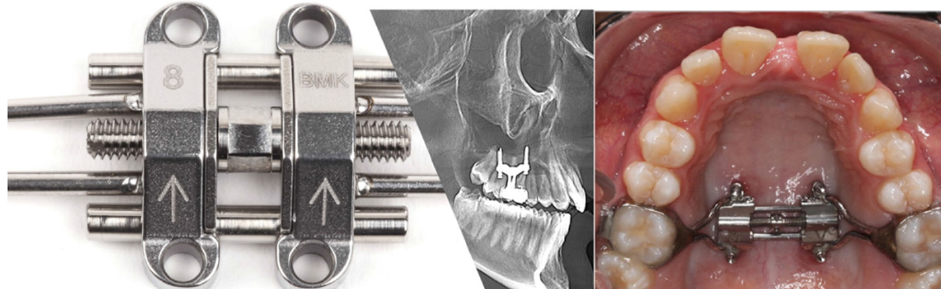
Figure 1. Maxillary Skeletal Expander device together with an X-ray showing the bicortical engage- ment and a photo demonstration of its intraoral application.